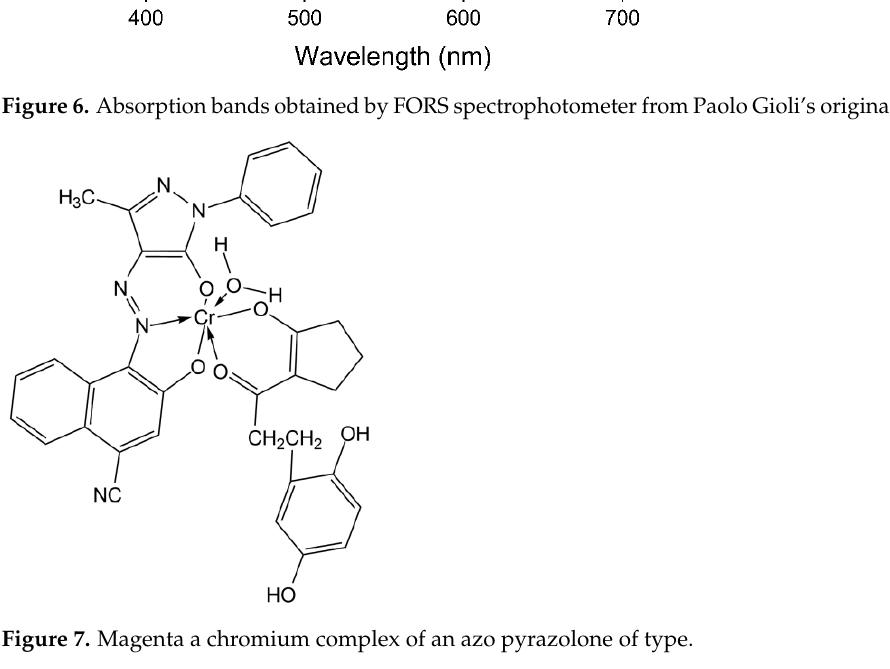
Table 4. Bands of the FTIR spectra of points GF1, GF2, G5, and paper. Acquisition Point